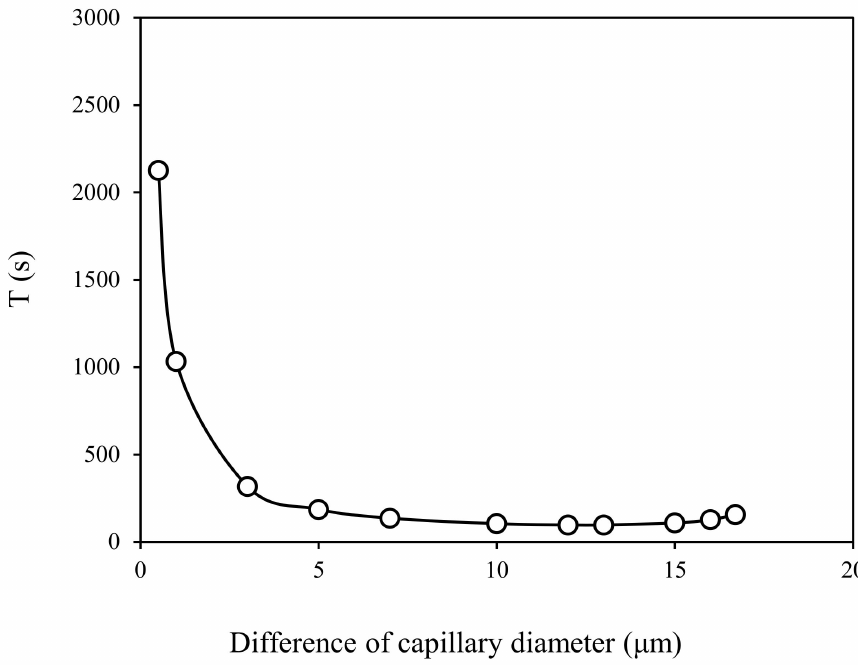
Figure 6. Relationship between imbibition time and capillary size